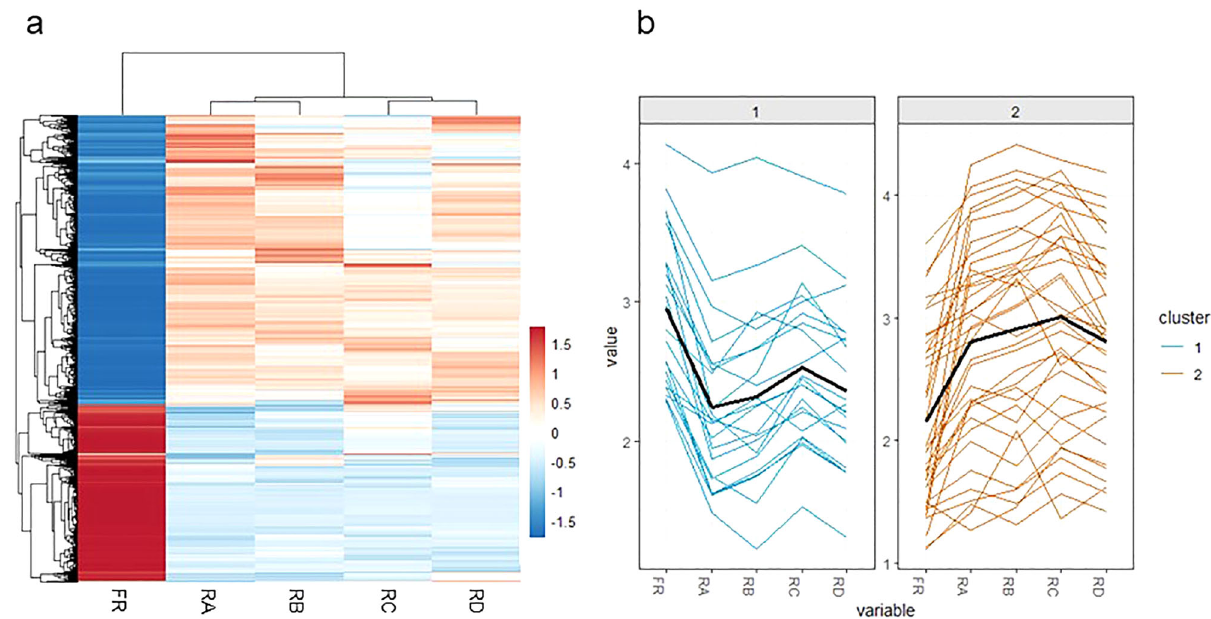
Fig. 2 Differential gene expression patterns in A. avenae during water loss. a Heatmap of global differential gene expressions in A. avenae during water loss. The color represents the z-scores of the expression values of the genes, which were calculated as the mean-centered FPKM values. b Expression of 58 DGE across fi ve conditions. FR: 100% rh, RA: 97% rh, RB: 85% rh, RC: 40% rh, RD: 0%